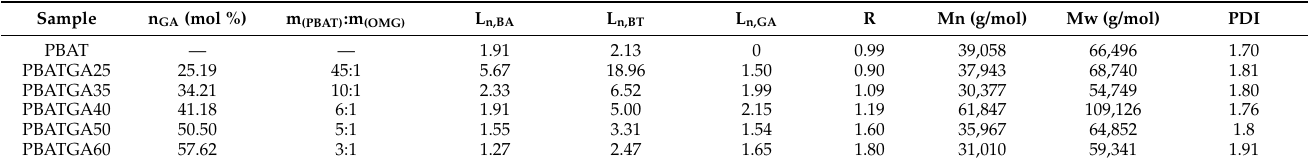
Table 1. Structure properties and molecular weights of